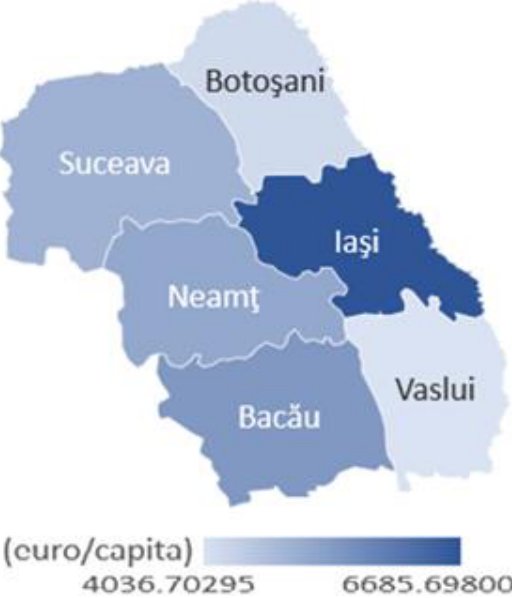
Figure 3. GDP per capita of NEDR (Romania). Source: Data processed by the authors (https://ec.eu- ropa.eu/eurostat/web/main/data/database, accessed on 14 April 2022).